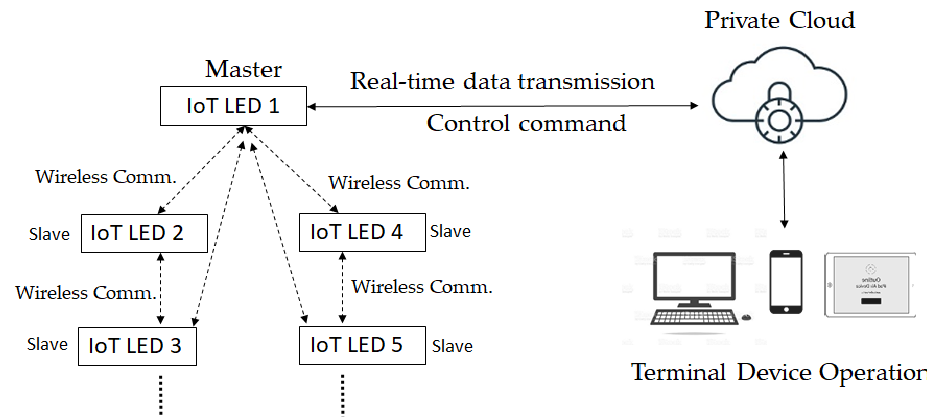
Figure 5. System architecture (see Figure 6 for the hardware block diagram of IoT LED).